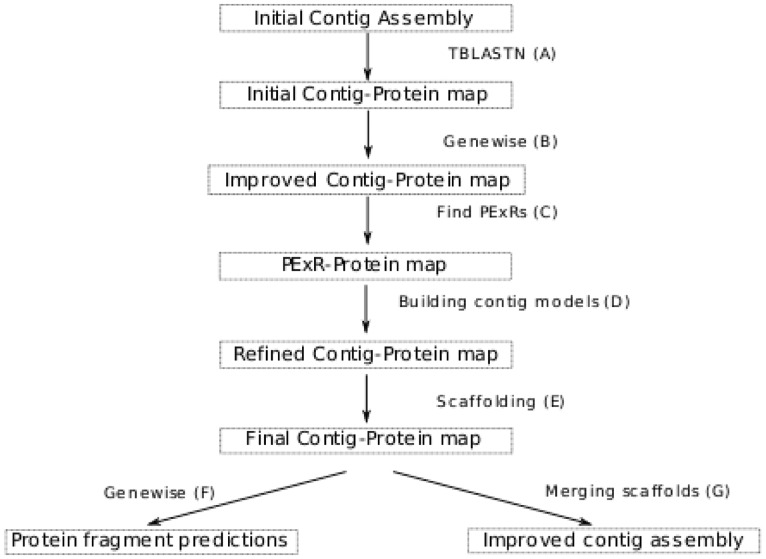
(A) Proteins in the chosen
guide proteome are mapped to contigs in the initial assembly with tblastn. All
overlapping mappings considered to be significantly worse than the best one are
removed. (B) Proteins with good mappings on contigs are re-aligned with
genewise to obtain single nucleotide resolution of exon predictions.
(C) Putative Exonic regions (PExRs) are predicted by overlapping contig
regions containing multiple homologous protein fragments. (D) PExRs
within each contig are used to establish a refined contig–protein orthology
model, only allowing contigs to map to different proteins if the associated sets of
PExRs show no overlap. Then, contig gene models are built using this mapping.
(E) A score optimization heuristic is used to scaffold contigs
together according to the total score of protein models. (F) genewise
is used once again on the protein scaffolds to predict protein fragments.
(G) A graph theoretic approach is used to find the local order of the
contigs and their strand